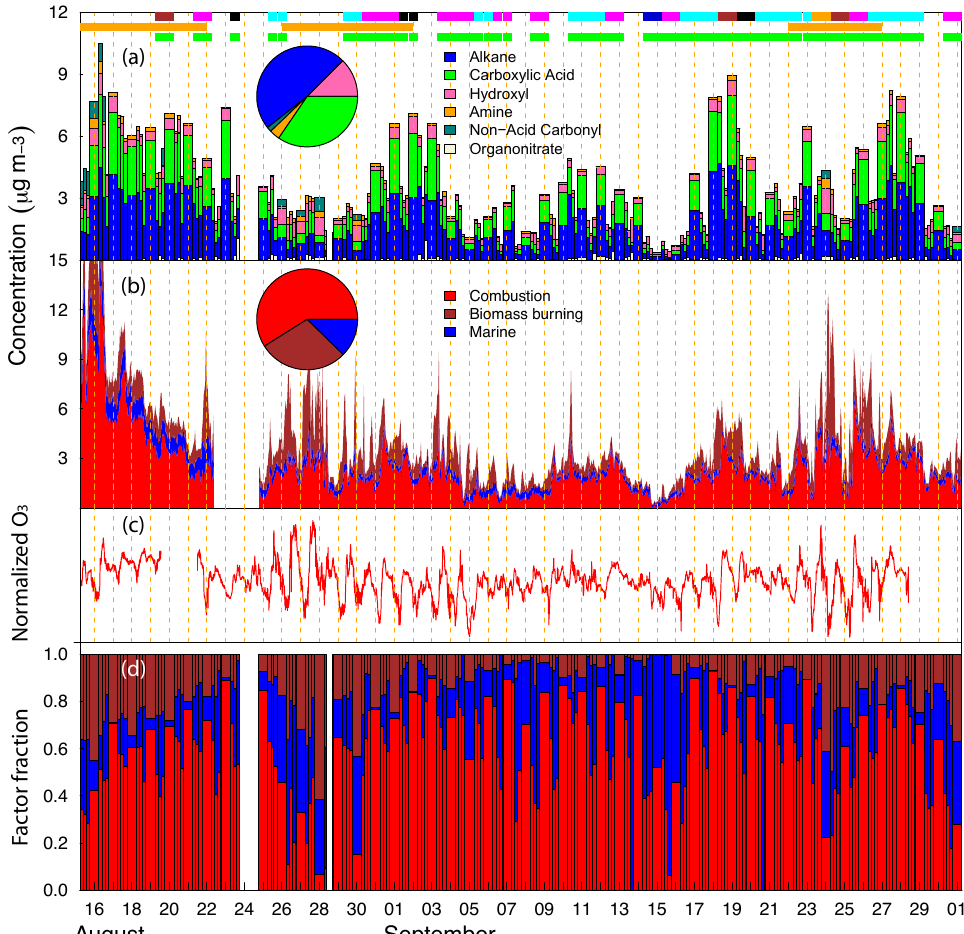
Fig. 2. (a) Time series of organic functional group concentrations measured by the FTIR; sectors are indicated by the top color bars (same colors as in Fig. 1), for which the sector associated with each FTIR sample was determined as the air mass origin shown by the majority ( > 80%) of the back trajectories during the sampling time; top brown bars indicate fire periods corresponding to the La Brea fire (in Santa Barbara County), the Station fire (in Los Angeles County), and the Guiberson fire (in Ventura County), respectively (from left to right); top green bars indicate samples that were used for diurnal profile analysis. (b) Time series of AMS factors identified by PMF analysis. The inner pie charts in (a) and (b) respectively show campaign average compositions of FTIR components and AMS factors. (c) Time series of normalized O 3 (normalized by campaign average) mixing ratio. (d) Mass fractions of the FTIR combustion factor (red), the biomass burning factor (brown), and the marine factor (blue) during the